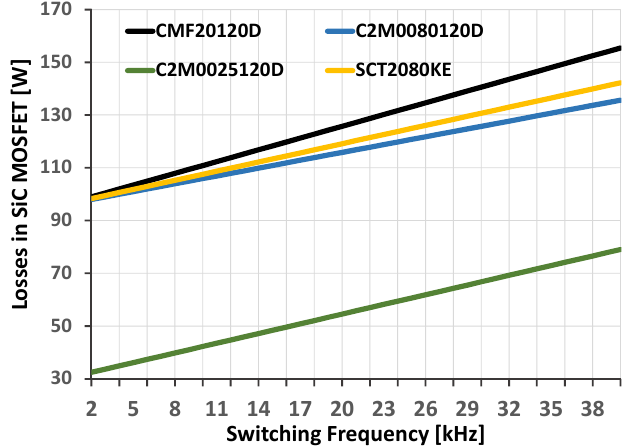
Fig. 7. P SEM performance index for analyzed SiC power MOSFETs in switching frequency range 2-40